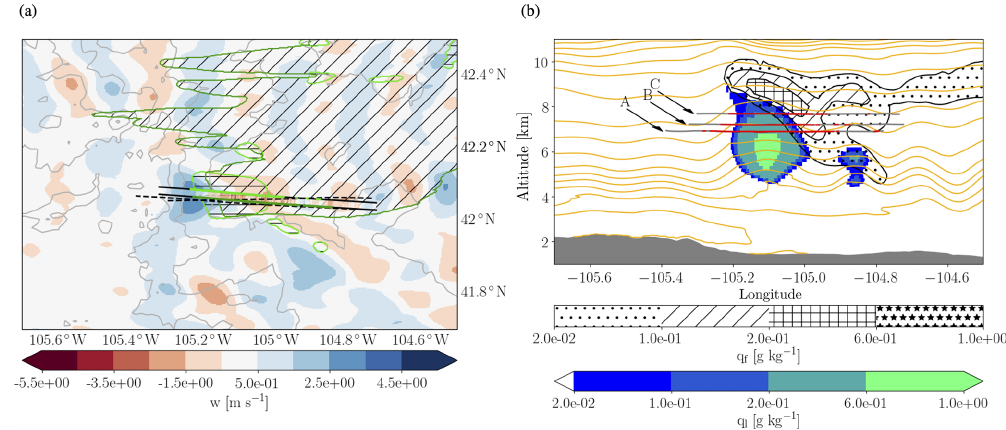
Figure 1. (a) The modelled vertical velocity field at 7200m, i.e. approximately the altitude of flight leg B, is shown by the colour shading (21:00UTC). The dark blue (cyan) contour and horizontal (diagonal) hatching indicates where liquid (frozen) cloud water content in the model exceeds 0.02gkg − 1 . The colour shading in the area between the two grey straight lines shows the observed vertical velocity along flight leg B, and the blue (green) colouring of the grey lines indicate observed cloud liquid (ice) exceeding 0.02gkg − 1 . The black dashed lines show the location of the aircraft legs at 6900 and 6780m. Black contours indicate the topography. (b) Vertical cross section through the wave cloud at 42.05 ◦ N (21:00UTC). The colour shading represents the modelled liquid water content; the contour lines with the hatching the modelled ice water content and the orange lines indicate isentropes. The horizontal lines show the projection of the flight path on the plane of the cross section, where red colouring of the lines indicates observed cloudy conditions (condensed water content larger than 10 − 7 kgkg − 1 ). The grey area at the bottom of the plot shows the